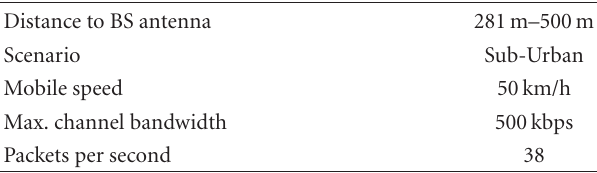
Table 4: Vehicular measurement parameters.